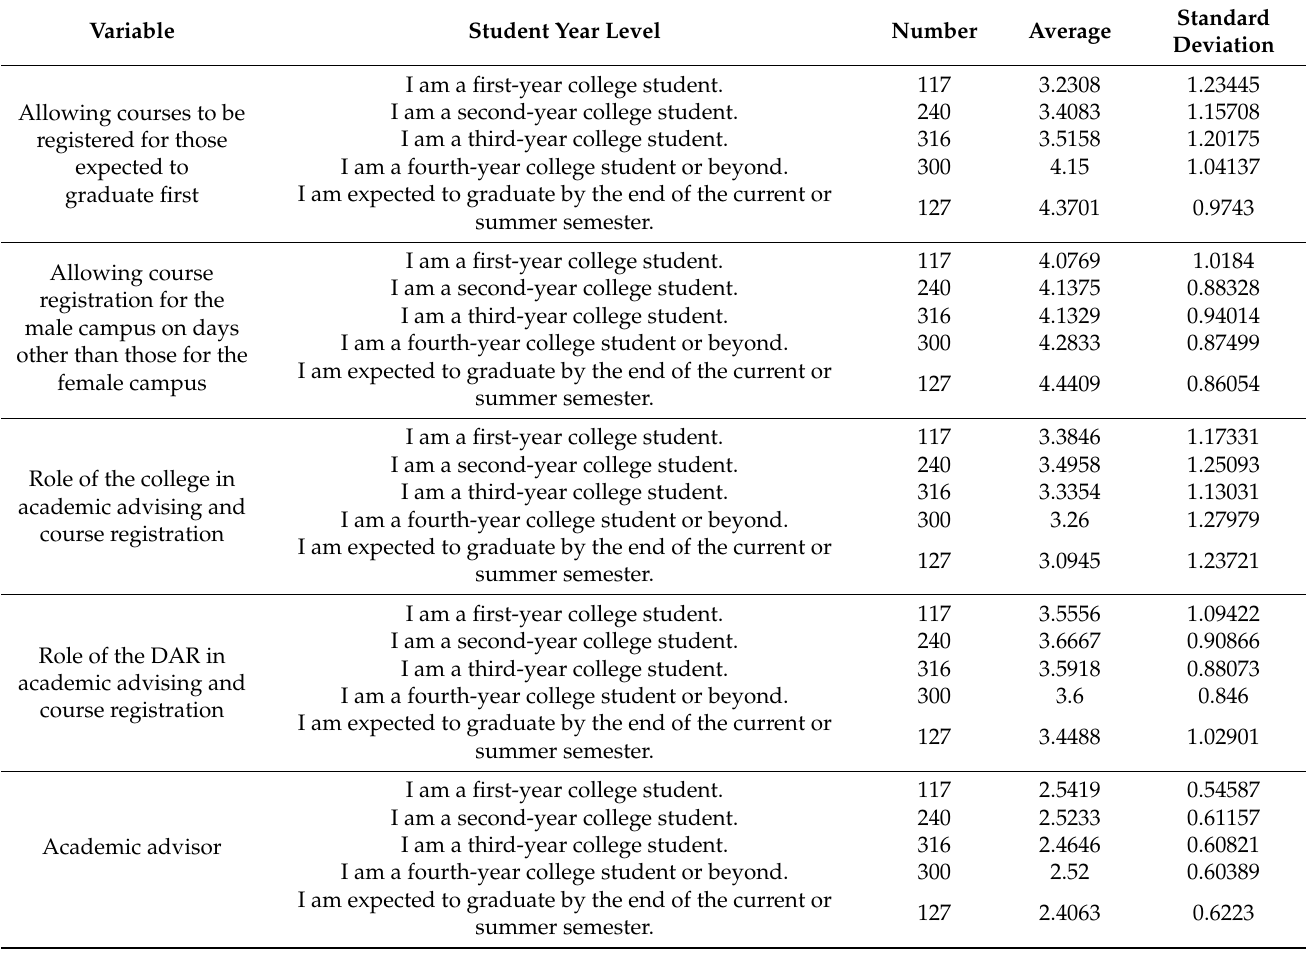
Table 18. Descriptive statistics of study variables by student year